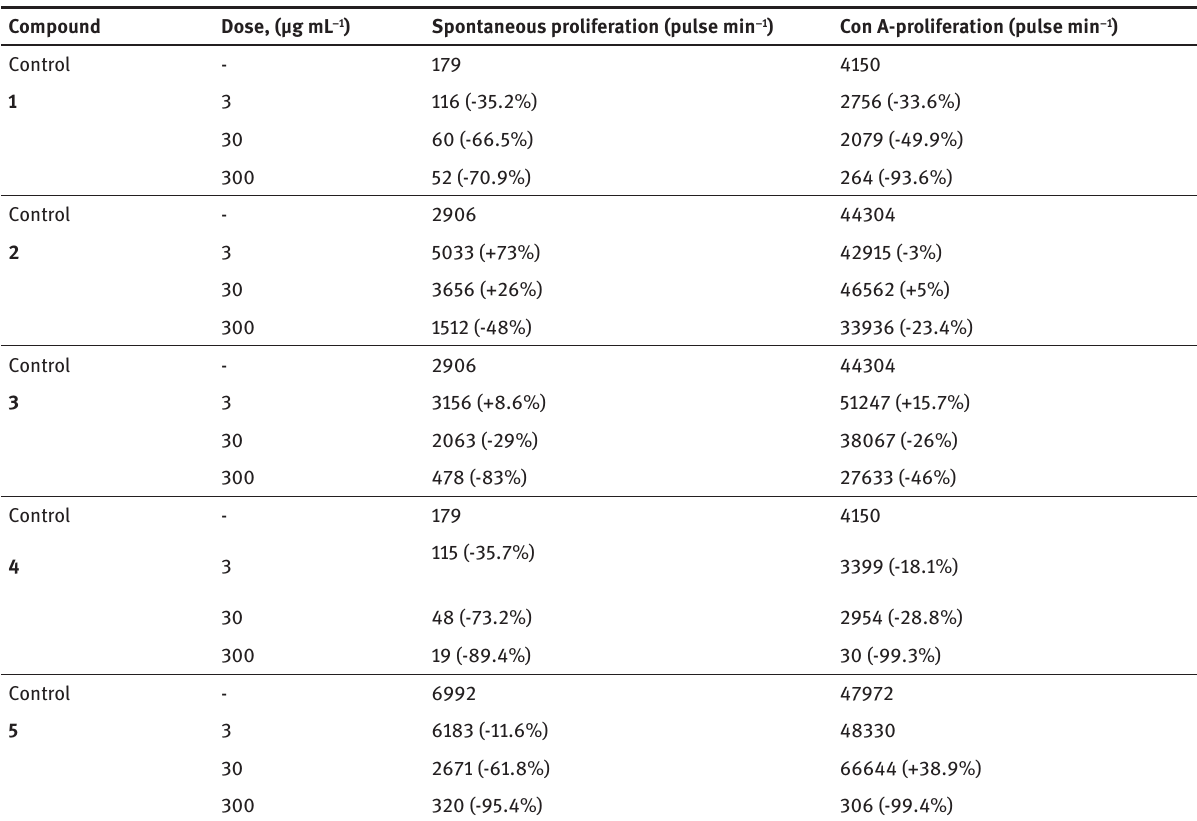
Table 4: Effect of compounds 1-5 on the spontaneous and mitogen-stimulated proliferation of spleen cells of intact mice in vitro .